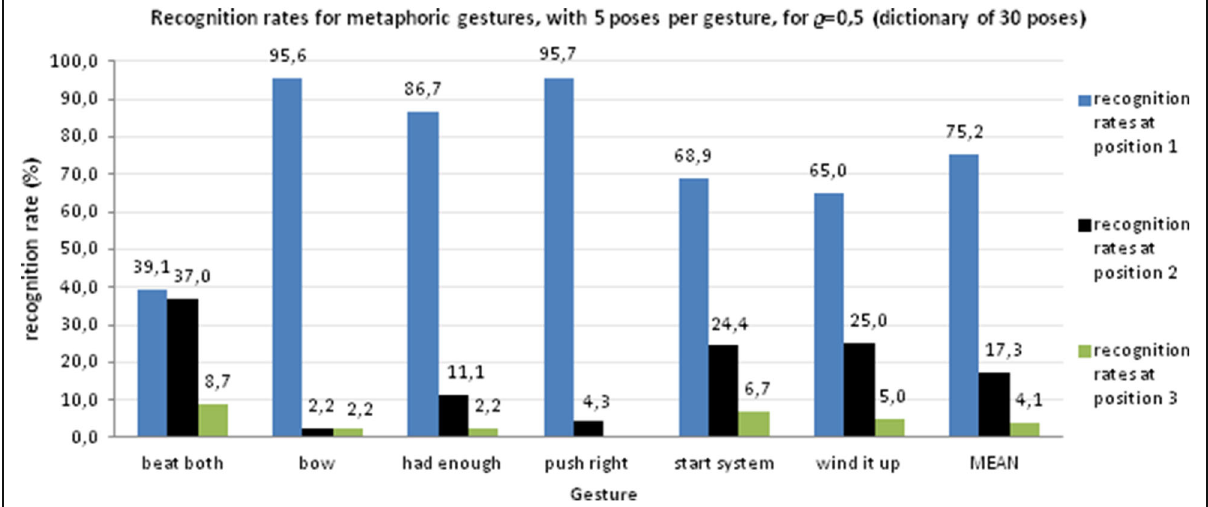
Fig. 8 Recognition rates for metaphoric gestures of MSRC-12 dataset